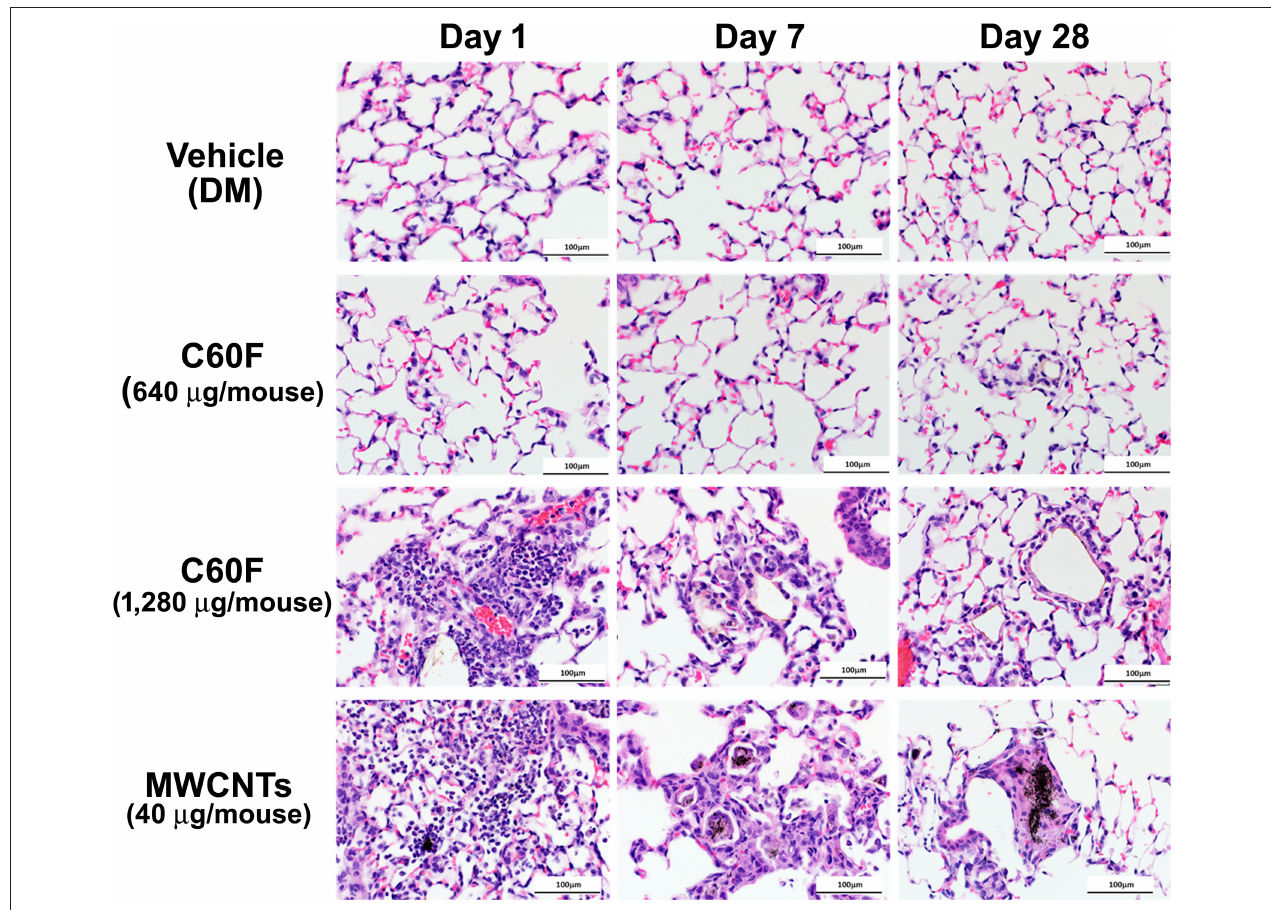
FIGURE 2 | Histopathology of ENM-exposed mouse lungs. Adult male B6C3F1 mice were given DM, MWCNTs (40 µ g), or C60F (640 or 1,280 µ g) by pharyngeal aspiration and were euthanized at days 1, 7, and 28 post-exposure for histological examination of the lung. Representative photomicrographs of H&E stained sections of mouse lung demonstrating pathology following particle exposure ( n = 3). Scale bar = 100 µ